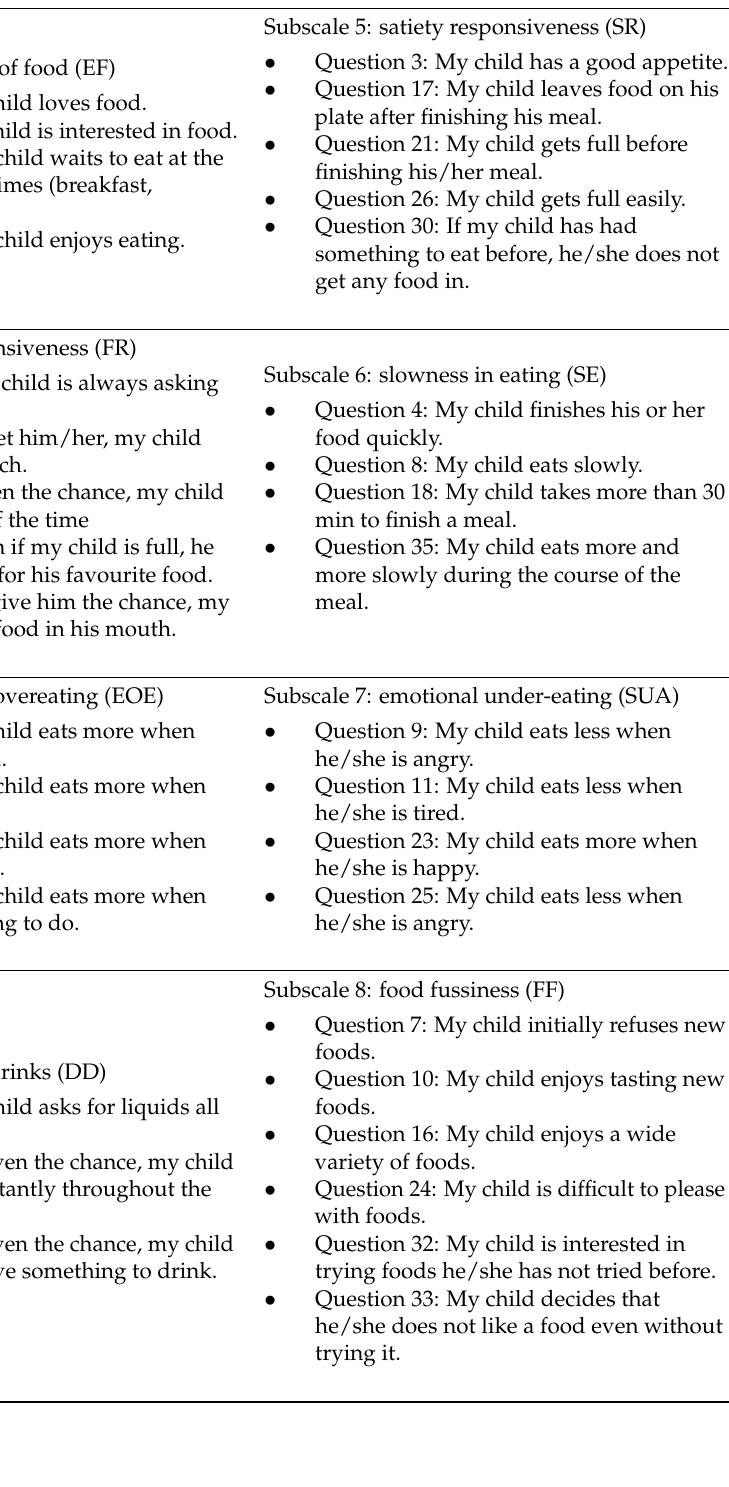
Table A2. Subscales of the CEBQ questionnaire [17]. Pro-Intake Criterion Anti-Intake Criterion